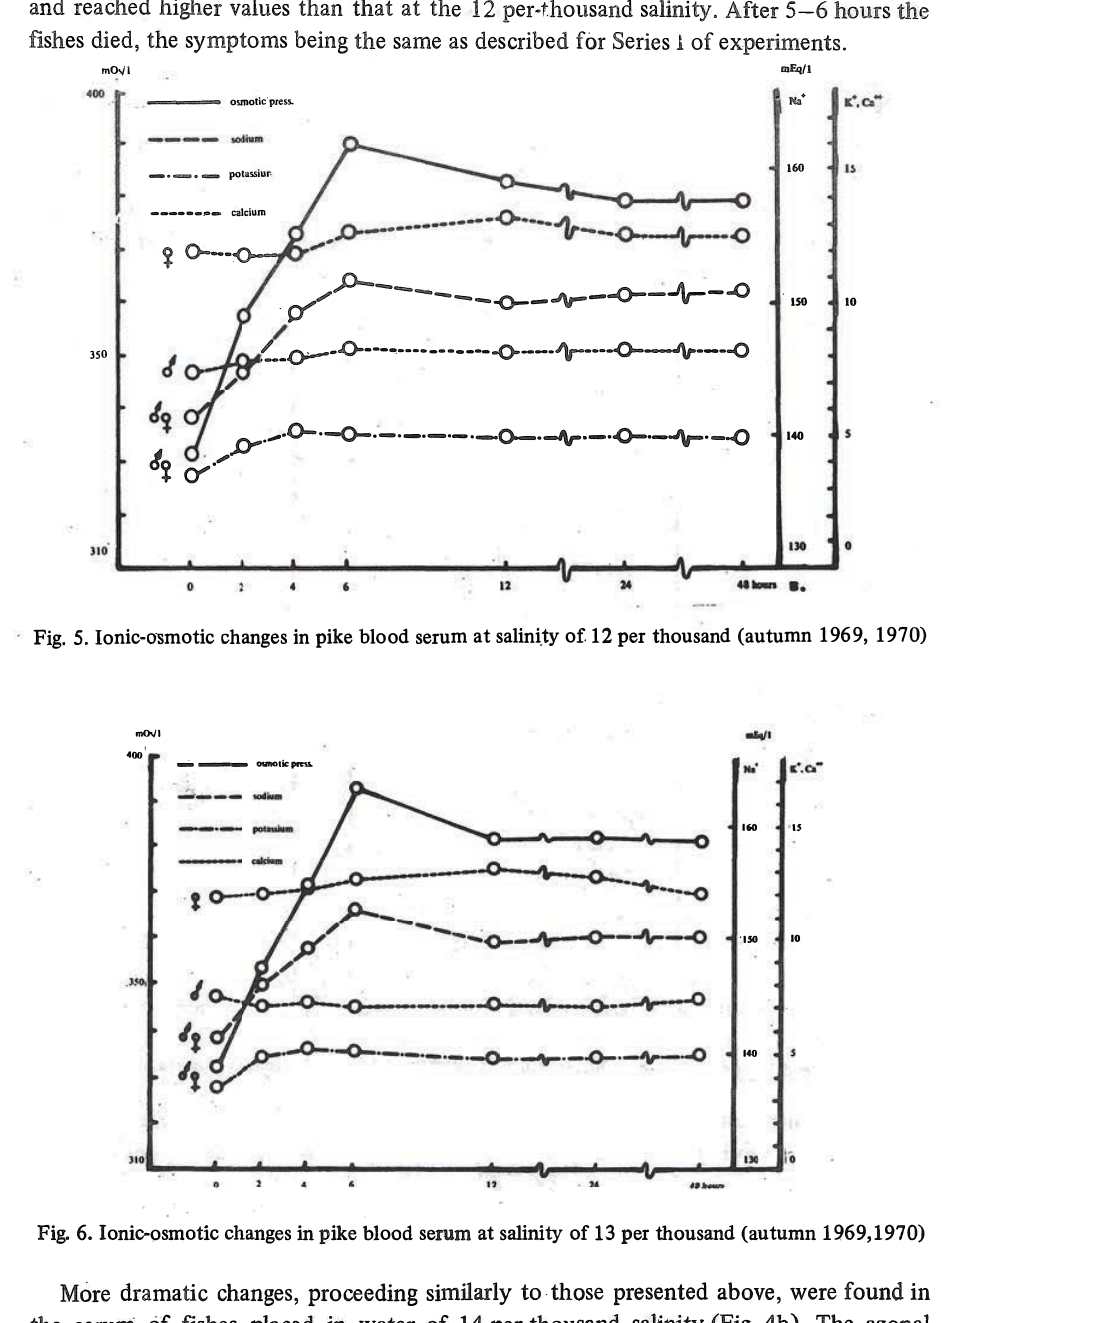
Fig. 6. Ionic-osmotic changes in pike blood serum at salinity of 13 per thousand (autumn 1969,1970) More dramatic changes, proceeding similarly to -those presented above, were found in the serum of fishes placed in water of 14 per-thousand - salinity (Fig. 4b ). The agonal phase hours after the t ransfer of